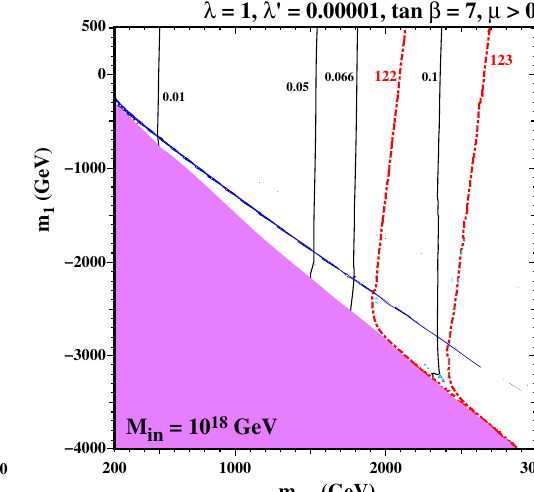
the dominant factor contributing to the Higgs mass is A t .